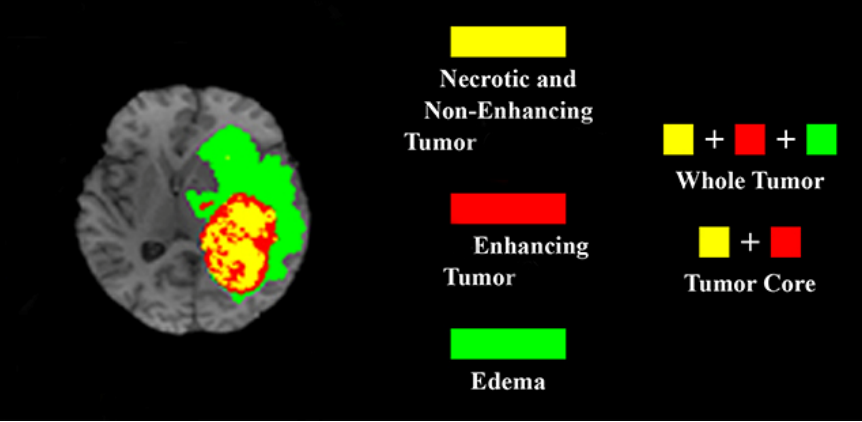
Figure 16. The three modalities of tumor regions: complete, core, and enhancing tumors.